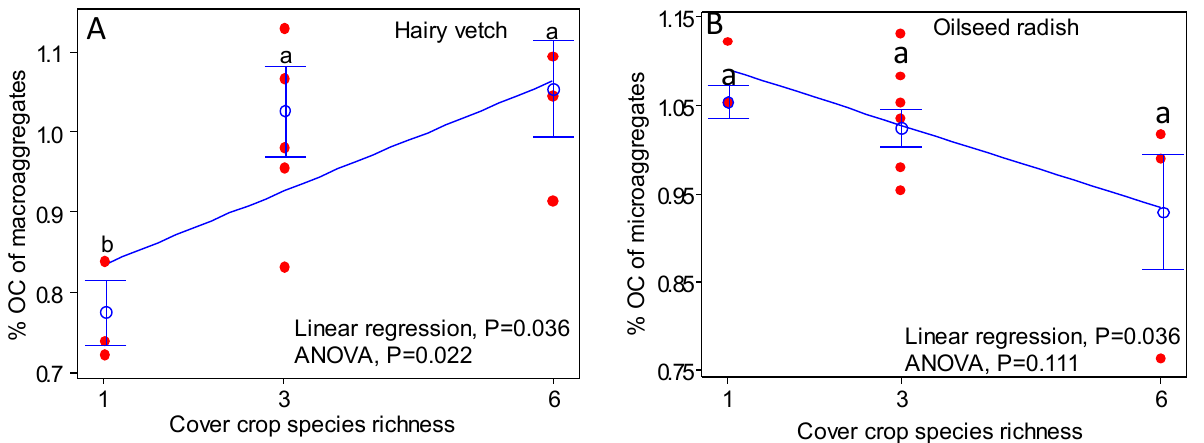
Figure 3. Individually comparing the OC contents of macrooaggregates ( A ) and microaggregates ( B ) under hairy vetch and oilseed radish against their corresponding 3- and 6-species mixtures across the cover plant diversity gradients. The red-filled circles represent data points of different replicates, while the empty blue circles reflect the mean point of data at respective richness levels. We are providing both linear regression and ANOVA results for a better understanding of the comparison between mixtures and monocultures in influencing the OC contents of macroaggregates and microaggregates. The error bars represent means ± 1SE whereas the lack of shared letters above the bars represents significant differences across different richness levels.